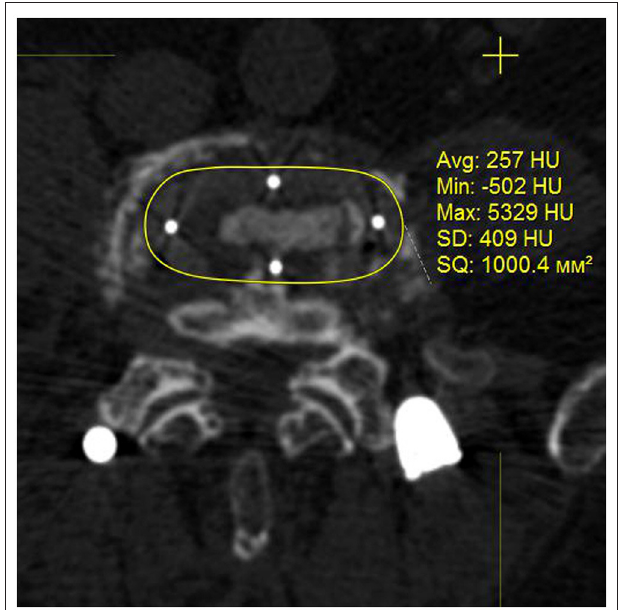
FIGURE 1 | Cage used for DLIF, postoperative CT image in axial plane.